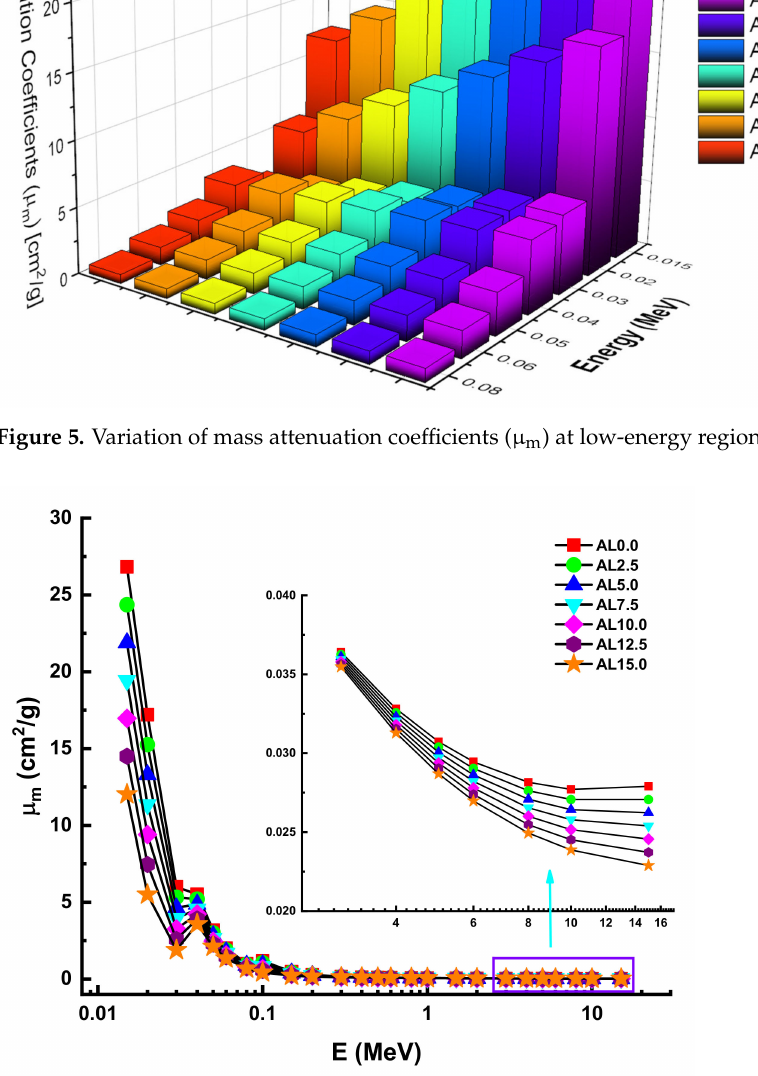
Figure 6. Variation of mass attenuation coefficient ( µ m ) against photon energy for all